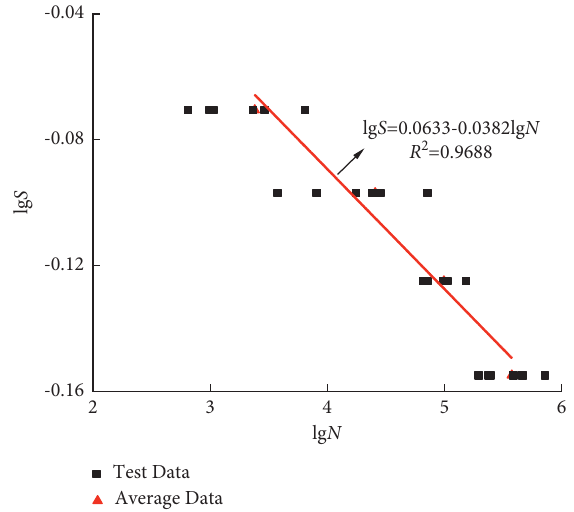
Figure 5: lgS-lgN curve of the average fatigue life of undamaged